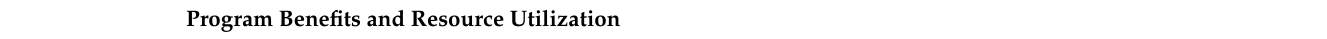
Table 2. Themes from questions assessing key opportunities for training, personal/professional development in the program, challenges faced, and suggestions for improving the